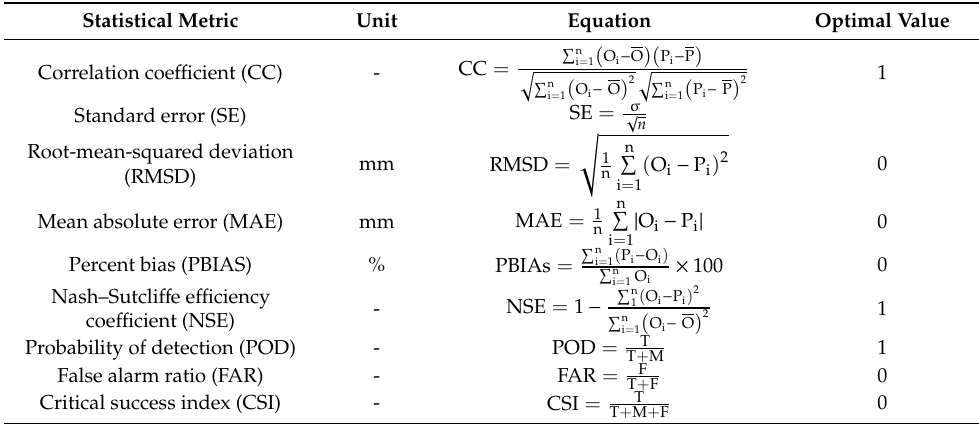
Table 3. The statistical metrics and their corresponding equations used for evaluating the overall performance of satellite precipitation